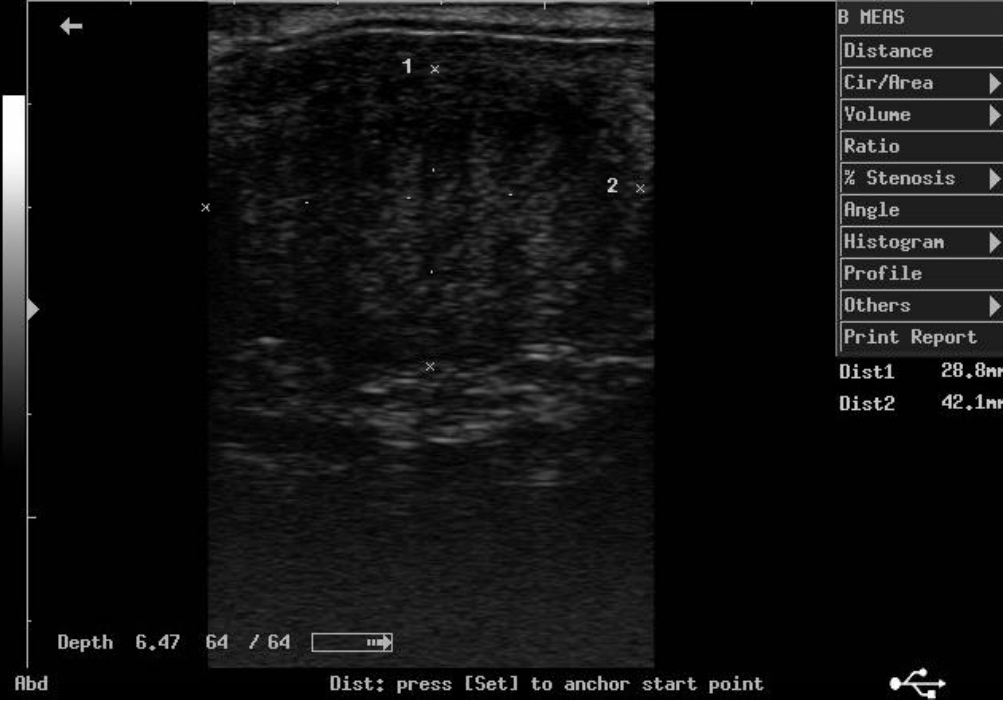
Figure 2. Ultrasound image of the middle tract of the non-post-pregnant uterine horn, at day 7 postpartum.